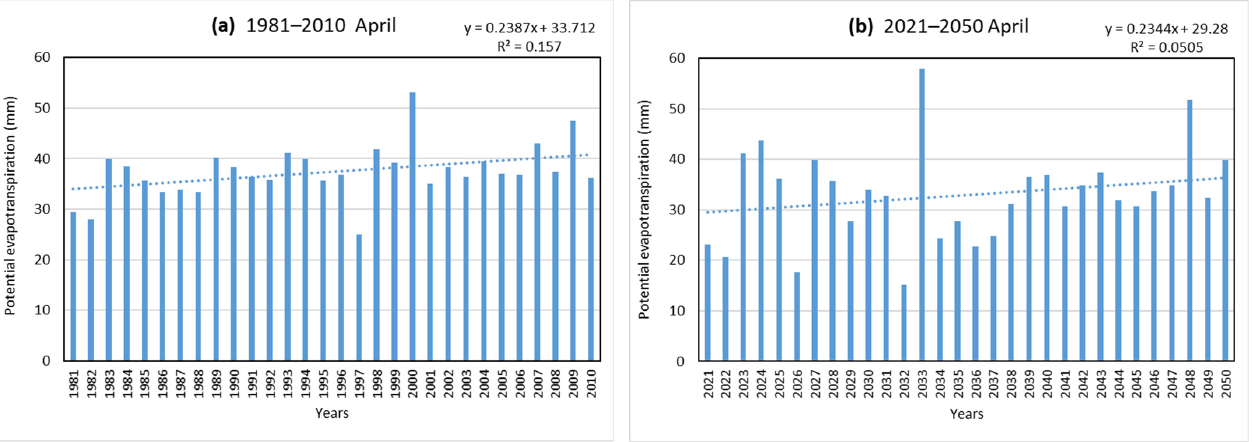
Figure 4. Time trend of sweet cherries' potential evapotranspiration in April in the reference ( a ) and forecast period ( b ). The trend line is marked with a dashed line.